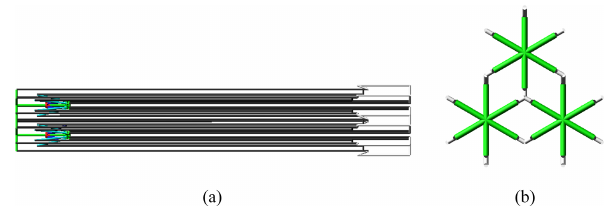
Figure 18. Folded state of deployable mechanism. (a) Side view. (b) Top view.